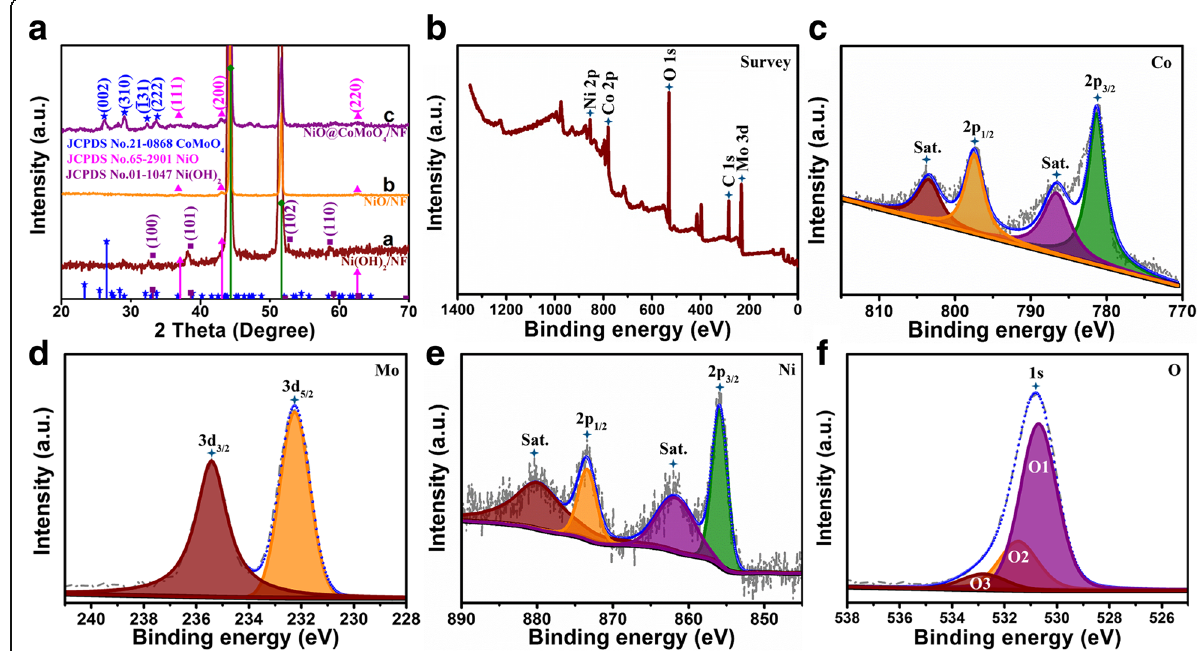
Fig. 2 a The XRD patterns of Ni(OH) 2 flakes/NF (curve a), NiO flakes/NF (curve b), and NiO flakes@CoMoO 4 NSs/NF (curve c). The XPS spectra of NiO flakes@CoMoO 4 NSs/NF. b Survey. c Co 2p. d Mo 3d. e Ni 2p. f O